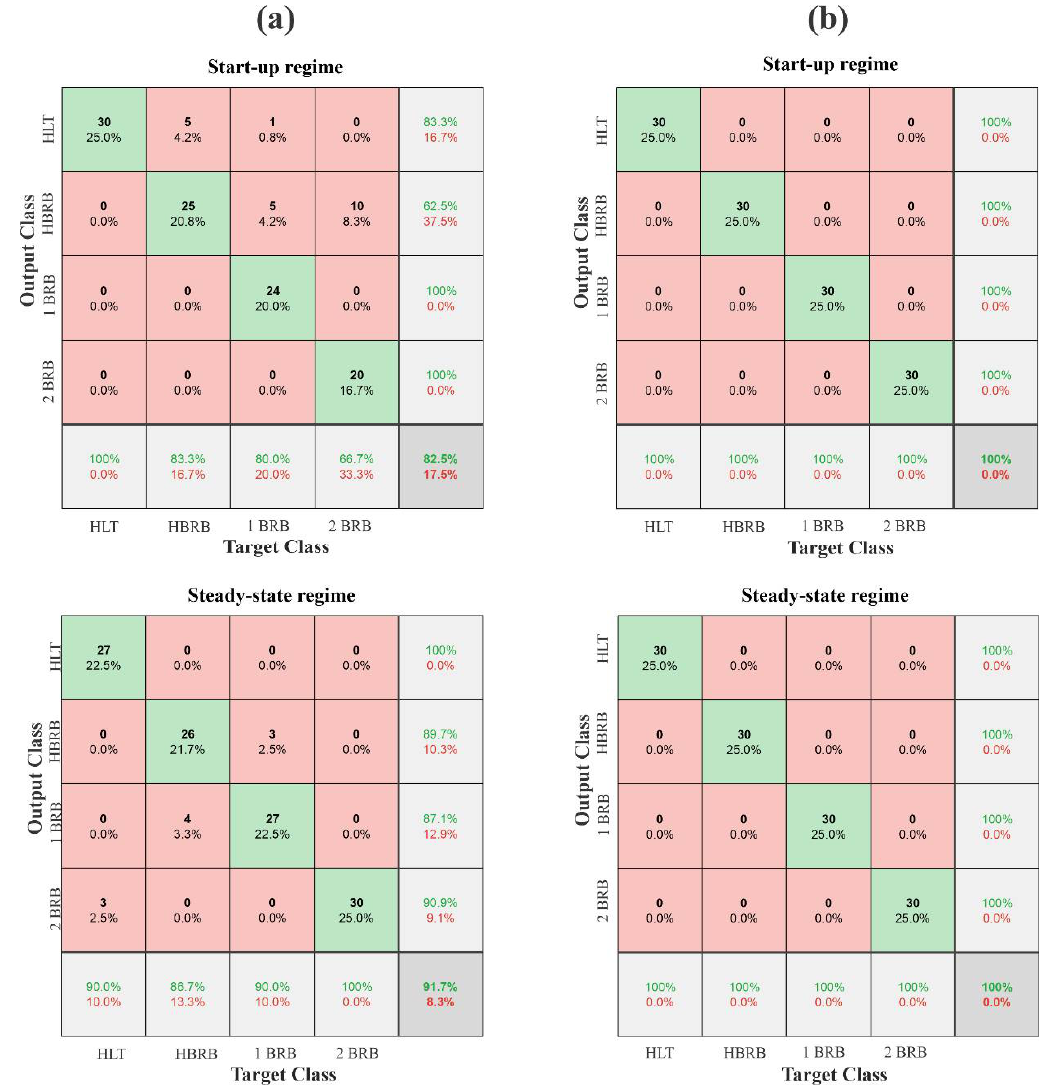
Figure 10. Confusion matrices for the analyzed current signal in both regimes (a) without and (b) with decimation stage.